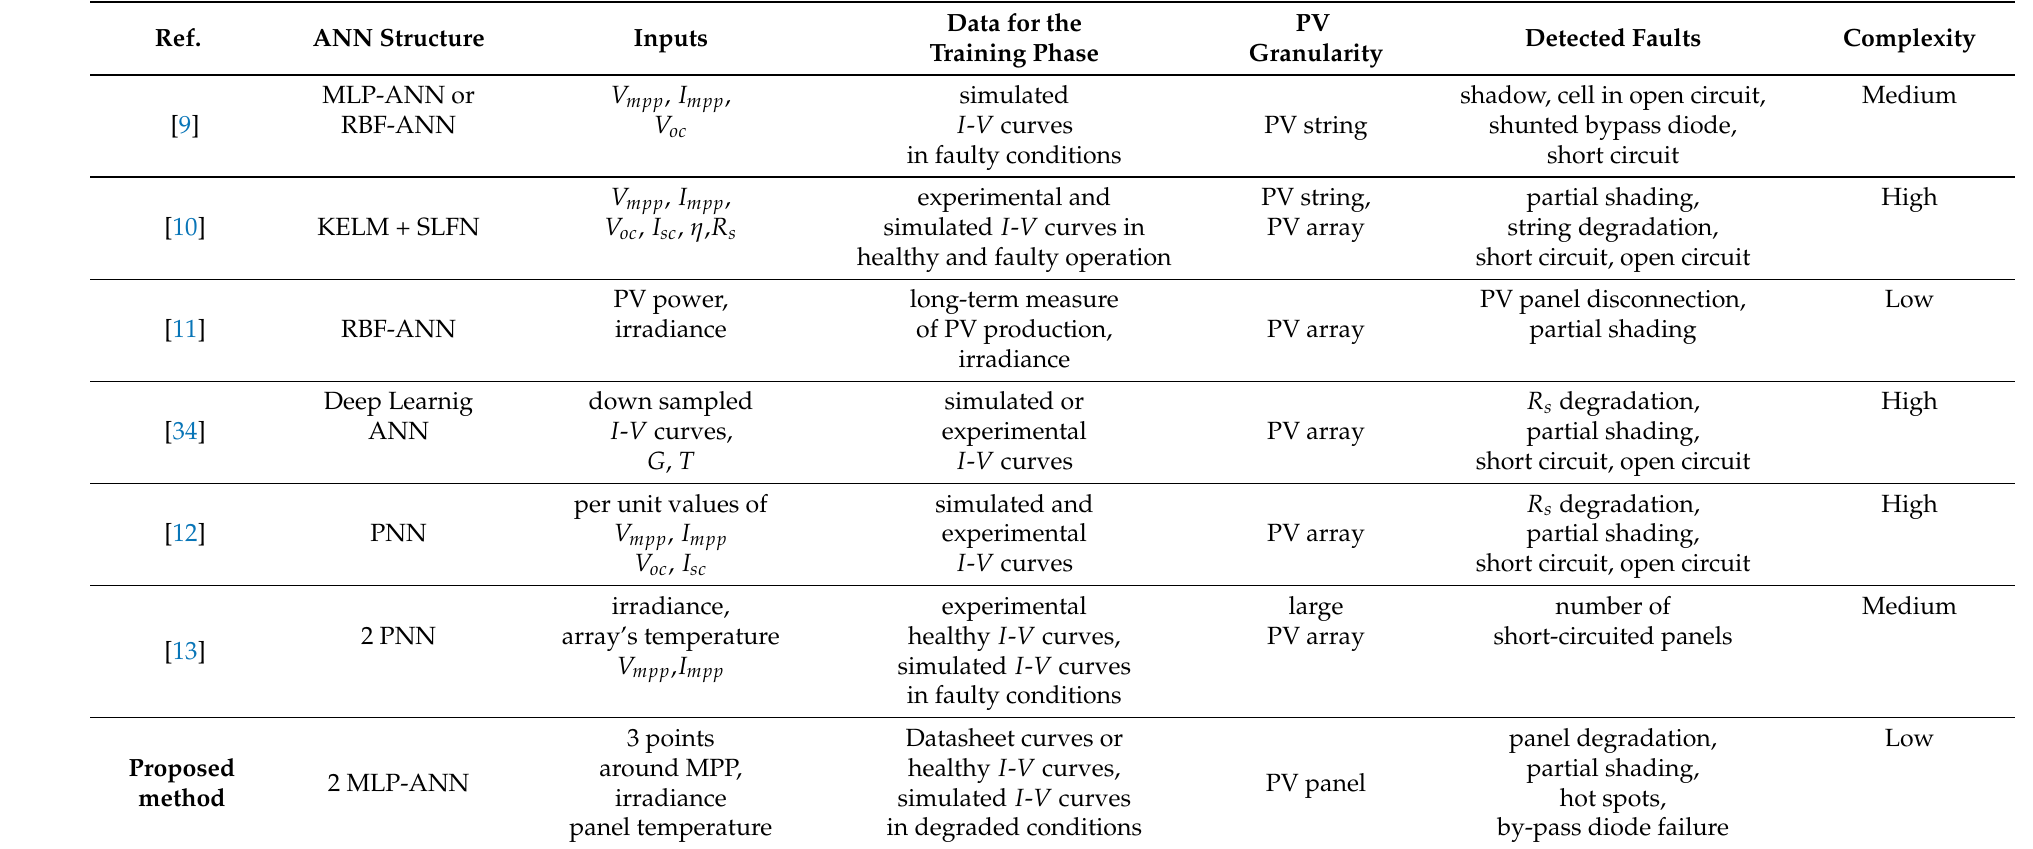
Table 11. ANN techniques for PV diagnosis and faults